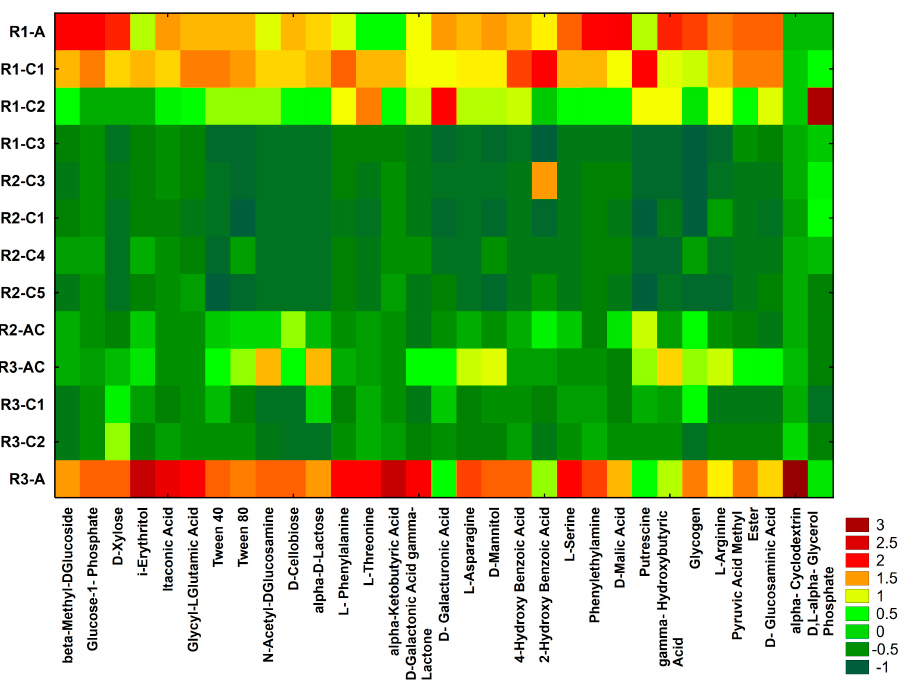
Figure 5. Heat map of carbon utilization patterns of 31 substrates from the Biolog ® EcoPlates™ incubates for 120 h from the studied soil profiles. The results are demonstrated as standardized data of absorbance measurement at 590 nm (the higher value means, the higher functional activity).